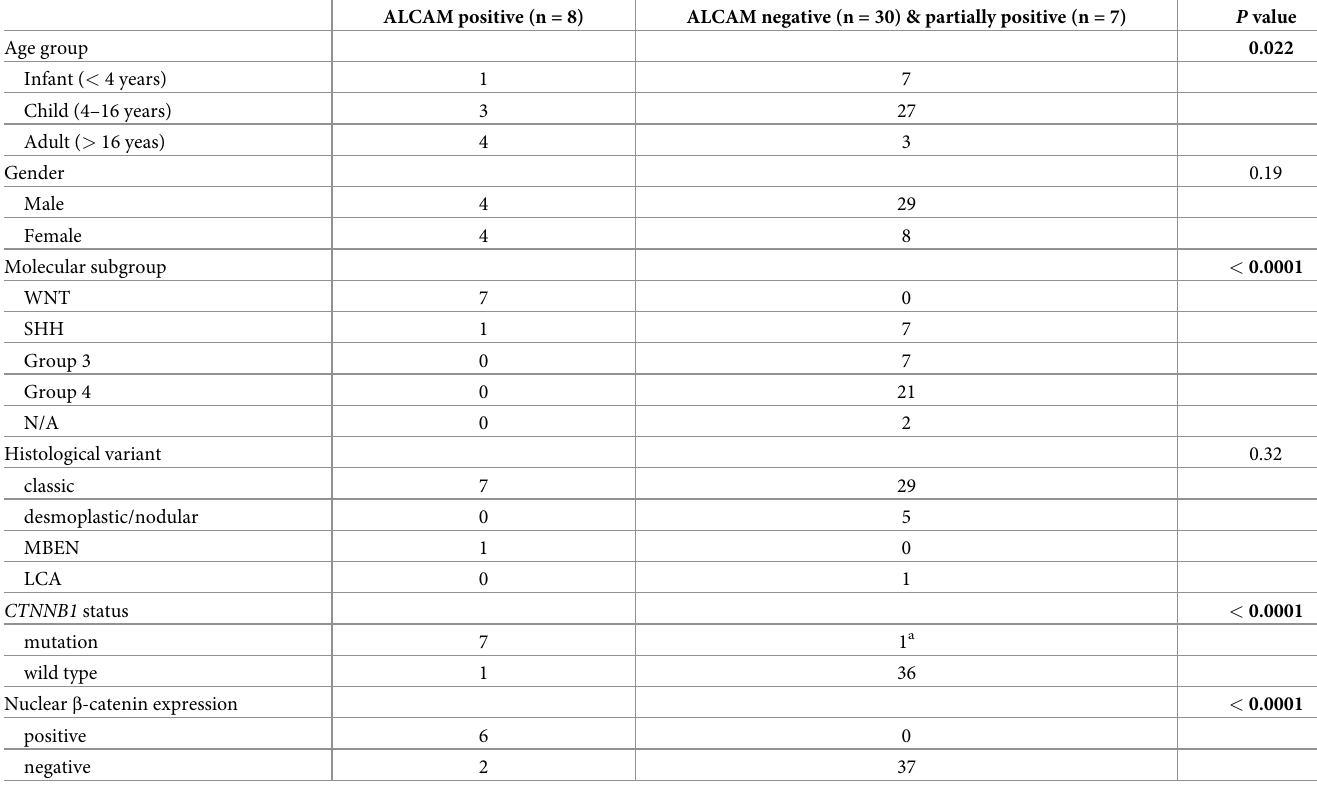
Table 1. Correlation between clinicopathological/molecular data and ALCAM